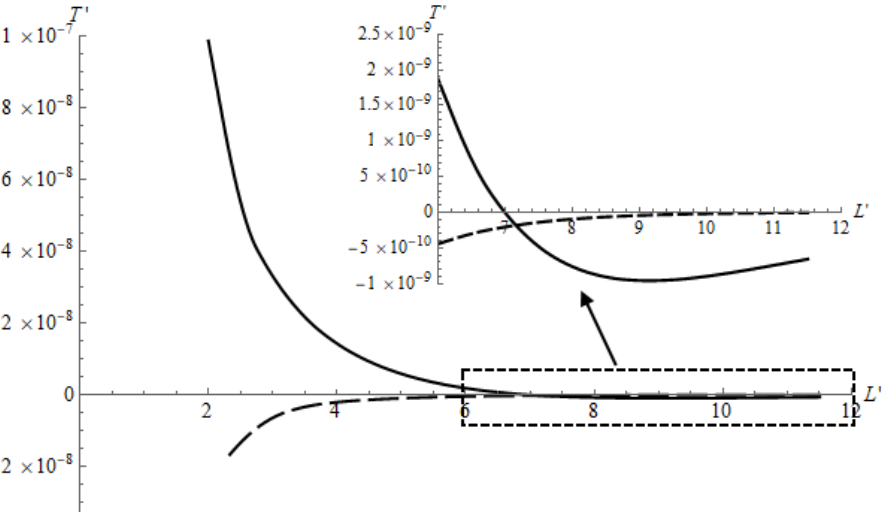
Figure 12. Tangential force as a function of the distance between the ball centers. E ν 1 = 0.48, ν 2 = 0.3, h (cid:48) = 1.16 ( dashed line ) , h (cid:48) = 6.0 ( solid line ) , Q (cid:48) = 2.66 ( 6 ) × 10 − 3